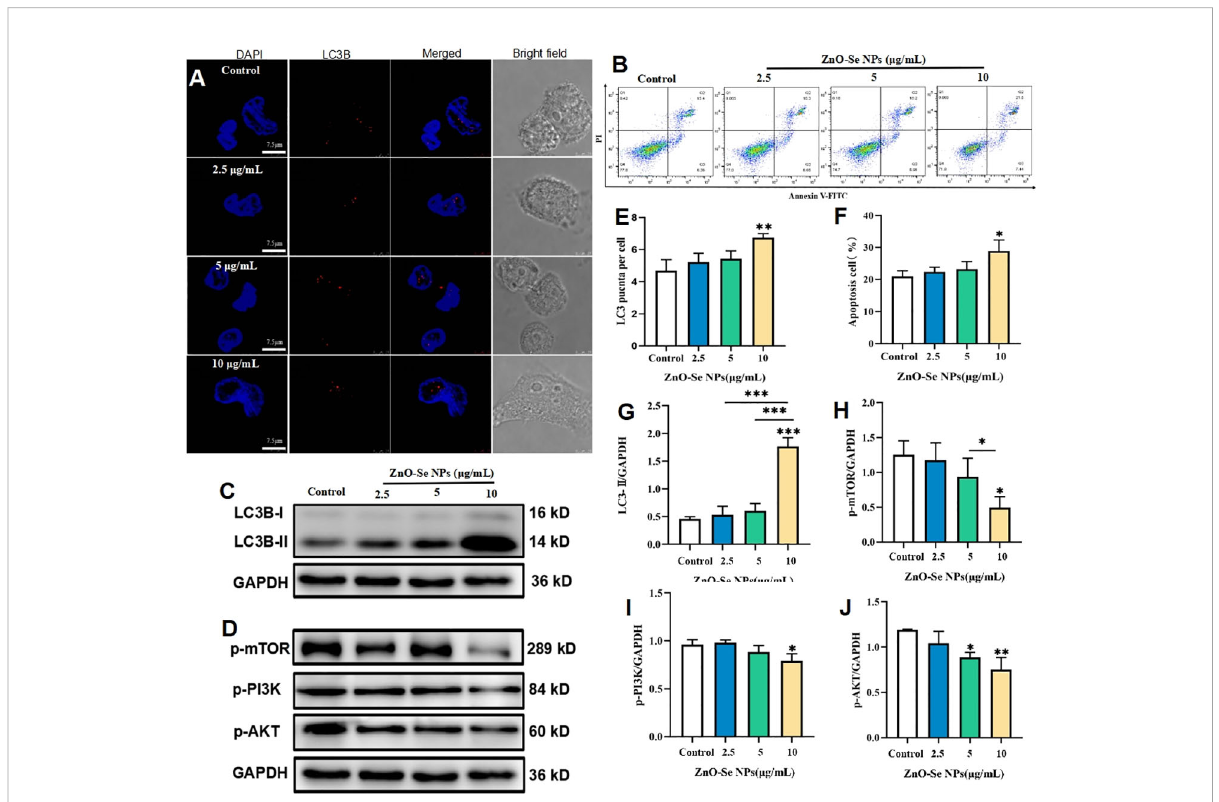
FIGURE 5 ZnO-Se NPs induce autophagy and apoptosis in Mtb infected macrophages by regulating PI3K/Akt/mTOR pathway. (A) Typical fl uorescence imaging of LC3B staining in BCG infected THP-1 cells before and after ZnO-Se NPs treatment, scale bar: 7.5 m m. (B) Typical fl ow cytometry analysis of apoptosis for BCG infected THP-1 cells before and after ZnO-Se NPs treatment. (C, D) Typical western blot results for (C) LC3B expression and (D) the phosphorylation of mTOR, PI3K and AKT in BCG infected THP-1 cells before and after ZnO-Se NPs treatment. (E) Statistical results of LC3B punctas for BCG infected THP-1 cells before and after ZnO-Se NPs treatment. (F) Statistical results of apoptosis for BCG infected THP-1 cells before and after ZnO-Se NPs treatment. (G) Statistical results for the LC3B expression in BCG infected THP-1 cells before and after ZnO-Se NPs treatment. (H) Statistical results for the phosphorylation of mTOR in BCG infected THP-1 cells before and after ZnO-Se NPs treatment. (I) Statistical results for the phosphorylation of PI3K in BCG infected THP-1 cells before and after ZnO-Se NPs treatment. (J) Statistical results for the phosphorylation of AKT in BCG infected THP-1 cells before and after ZnO-Se NPs treatment, n ≥ 3, *p<0.05, **p<0.01,